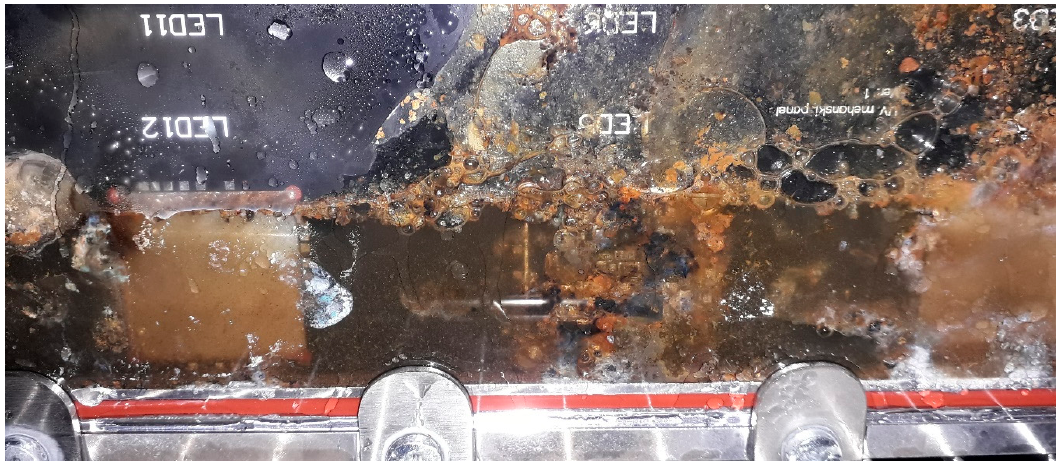
Figure 15. Accumulated water inside the enclosure after around 63 hours in the chamber, caused by insufficient sealing.